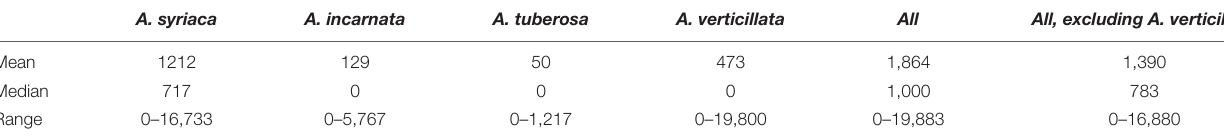
TABLE 2 | Milkweed density by species across sites (plants/ha) ( n =